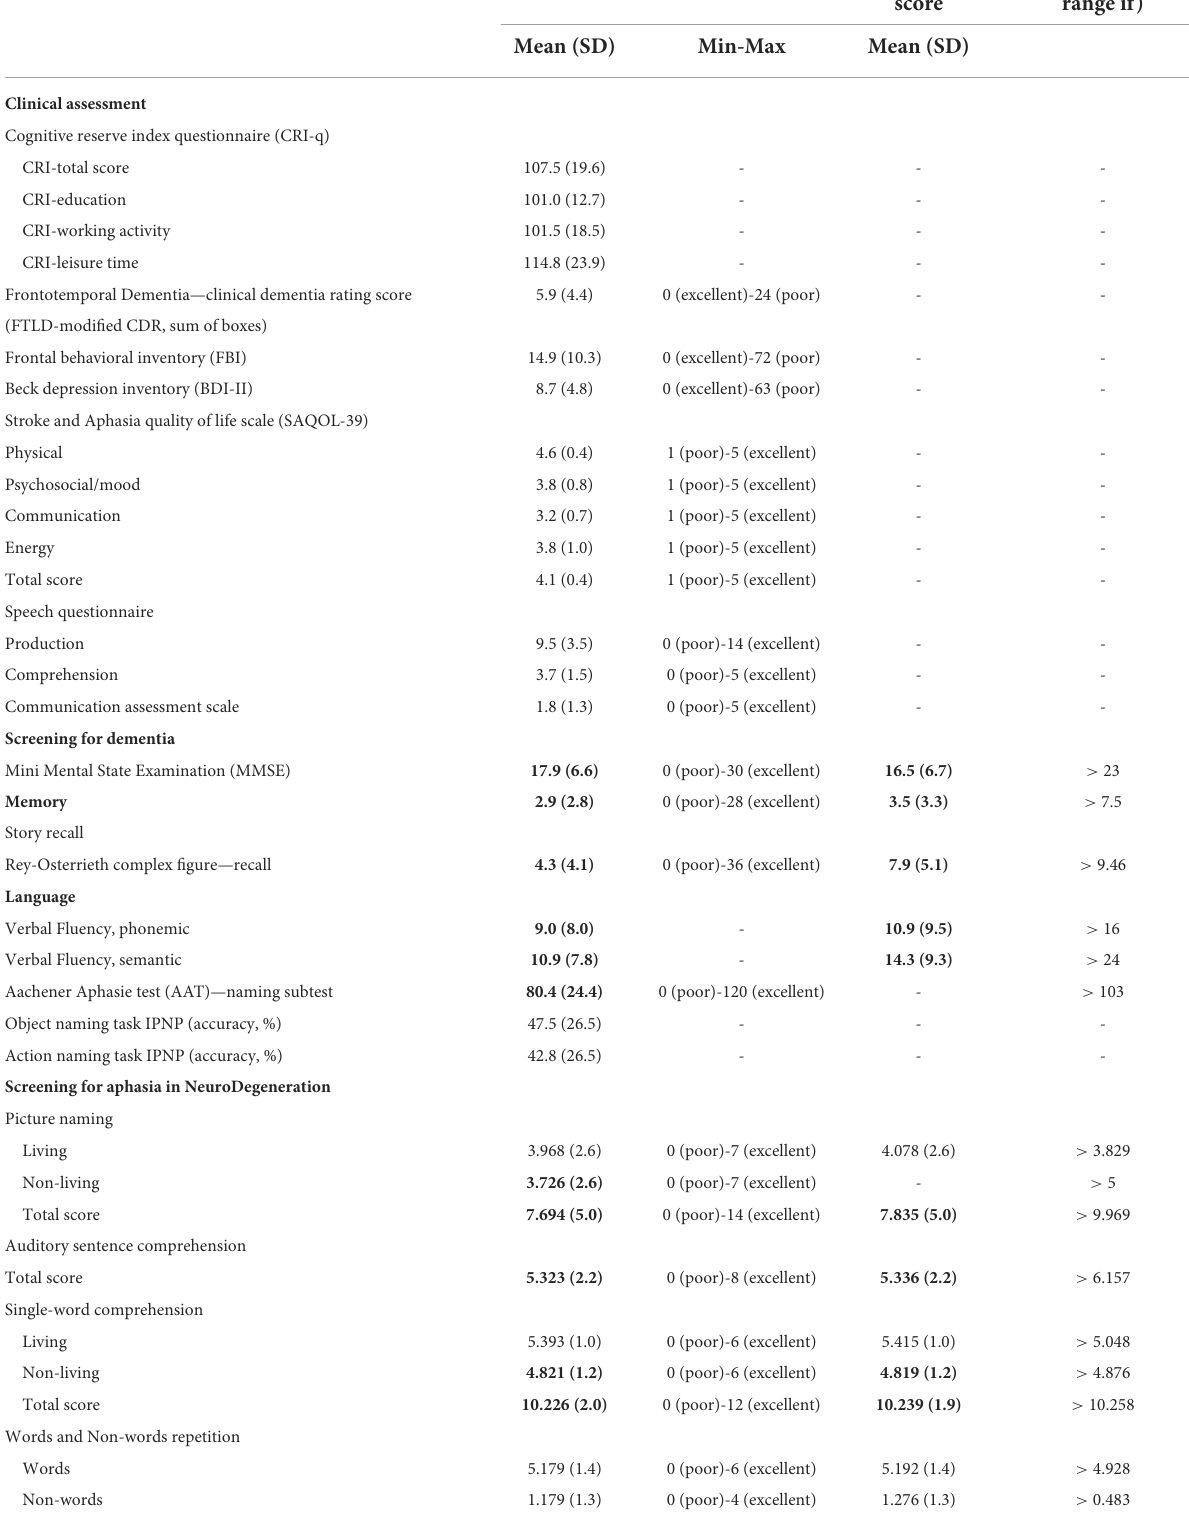
Cut-off (in the normal score range if)